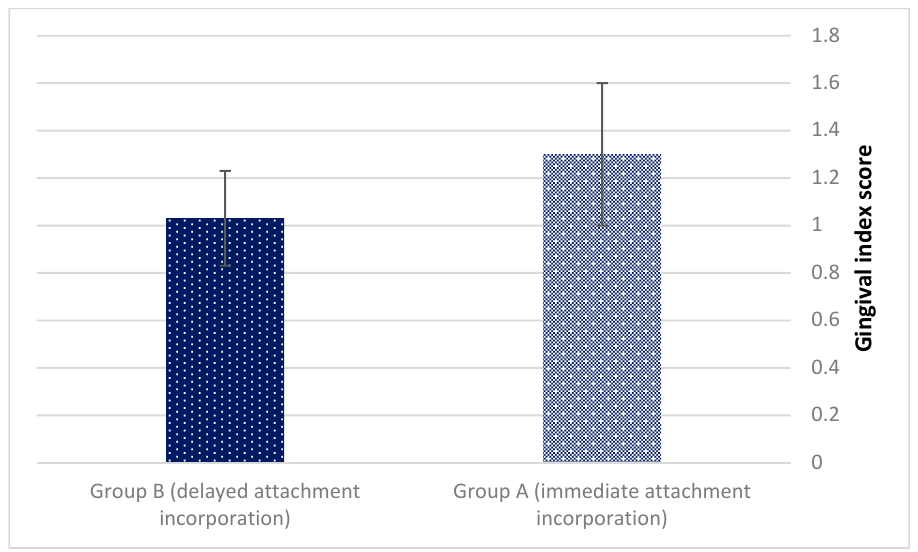
Figure 7. The mean Gingival index ( p = 0.653).